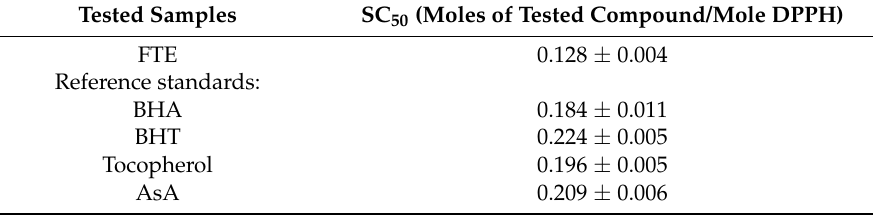
Table 1. The 50% inhibition of the DPPH scavenging effect, SC 50 (moles of tested compound/mole DPPH), induced by the FTE and the reference standards.